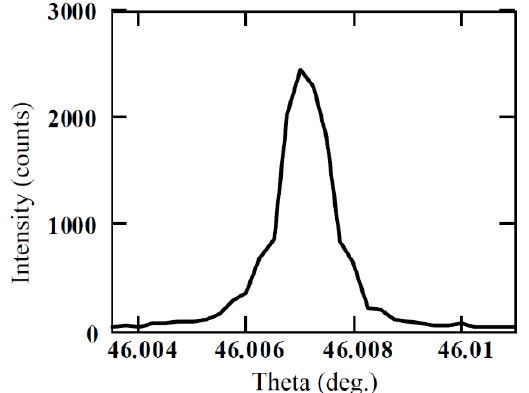
Figure 6. Rocking curve ((0008) reflection) of the 4H-SiC semi-insulating epitaxial layer (SI-M50) used for detector fabrication.